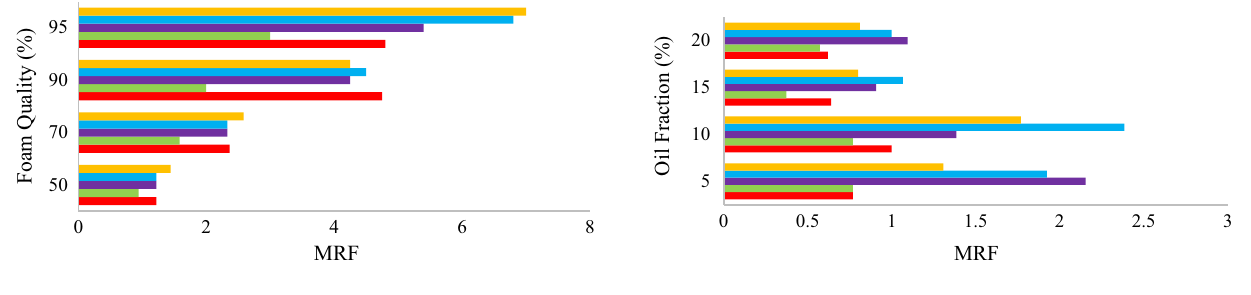
Fig. 7 MRFs at different foam qualities, and at 100 °C